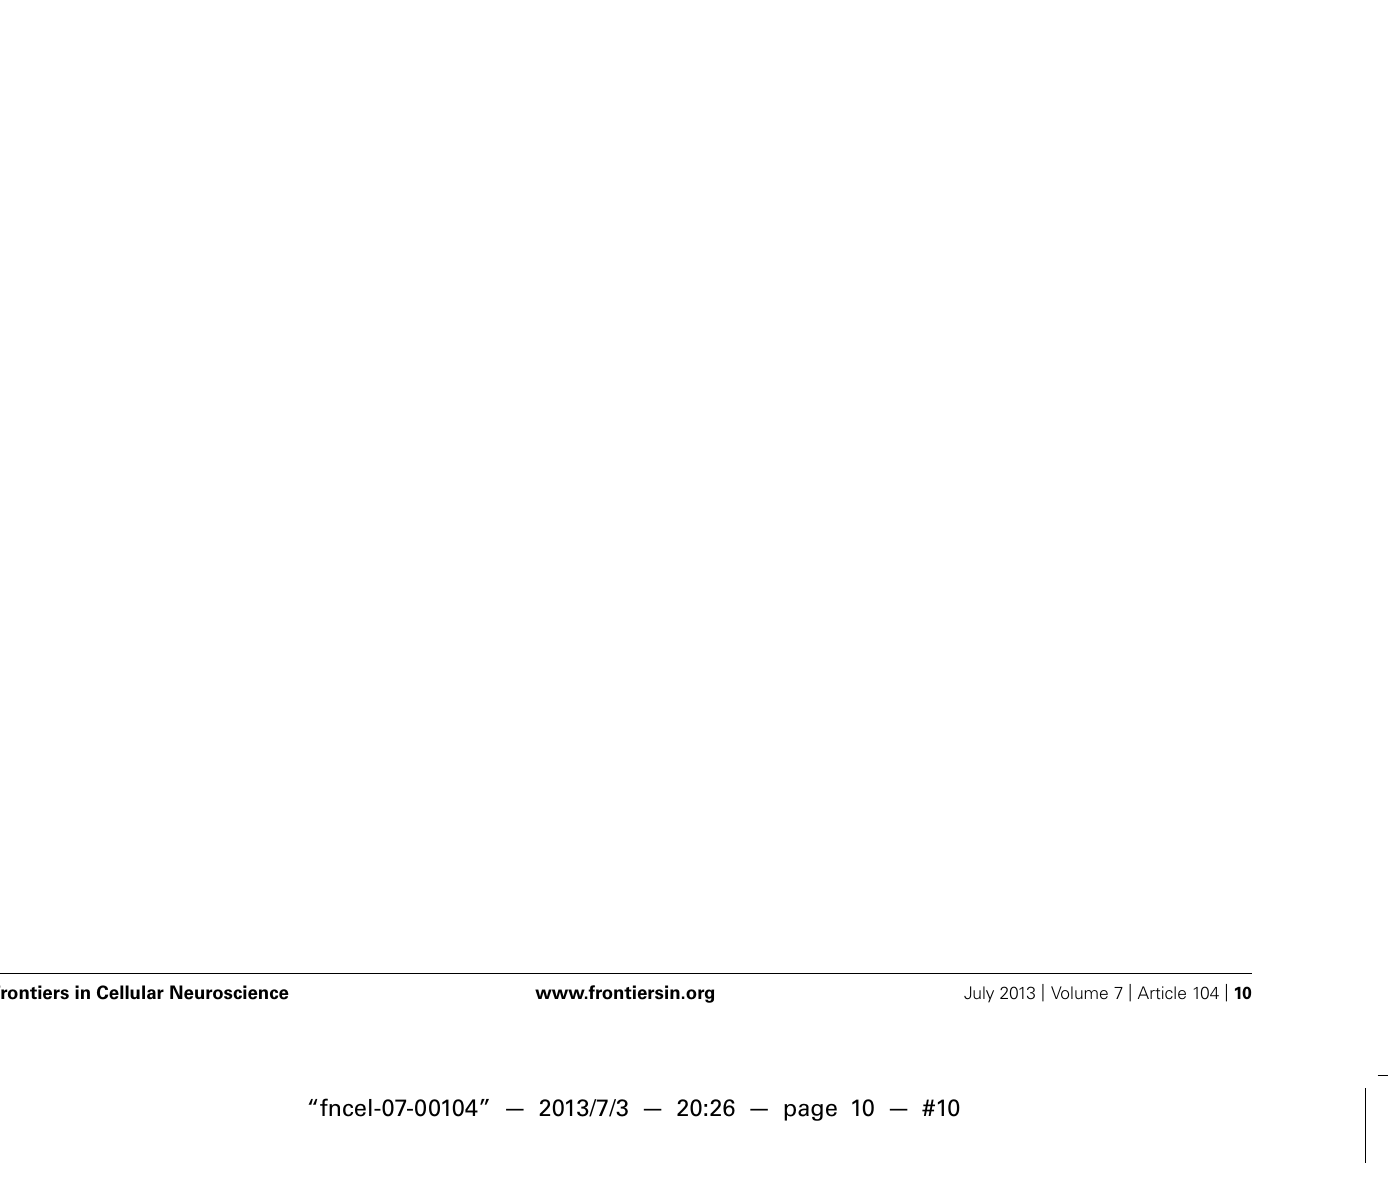
FIGUREA1 | Expressional patterns of Kir4.1 in the rat hippocampus. Typical photograph illustrating a double staining of Kir4.1 with GFAP in the hippocampal CA1 field.The hippocampal section was incubated anti-GFAP antibody (Progen, Heidelberg, Germany) for 24 h at 4 ◦ C and then incubated with a FITC (fluorescein isothiocyanate; green fluorescence)-conjugated goat anti-rabbit IgG secondary antibody (Sigma-Aldrich) orTRITC (tetramethylrhodamine-5- (and 6)-isothiocyanate; red fluorescence)-conjugated goat anti-mouse IgG secondary antibody